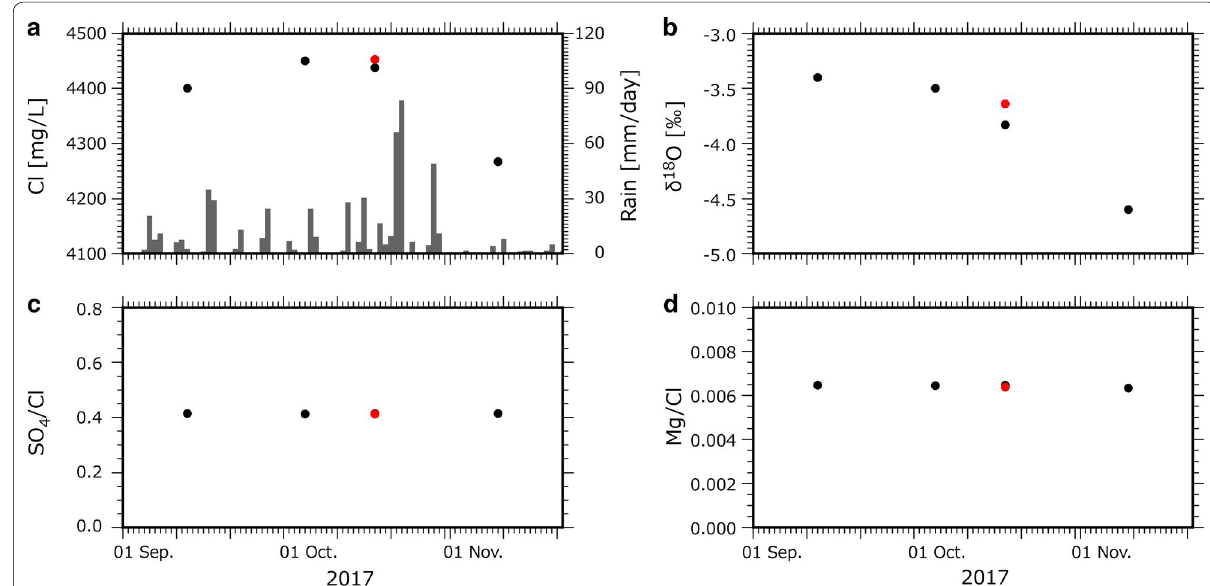
Fig. 4 Temporal changes in water chemistry in Yugama crater lake. Temporal changes in the chemical concentrations and stable isotope ratios of Yugama lake water sampled by drone at site B on October 18, 2017 (red closed circles), and regularly sampled by hand at site U1 from September to November in 2017 (black circles). a Cl ions and daily precipitation observed at Yugama crater, b δ 18 O, c SO 4 /Cl, and d